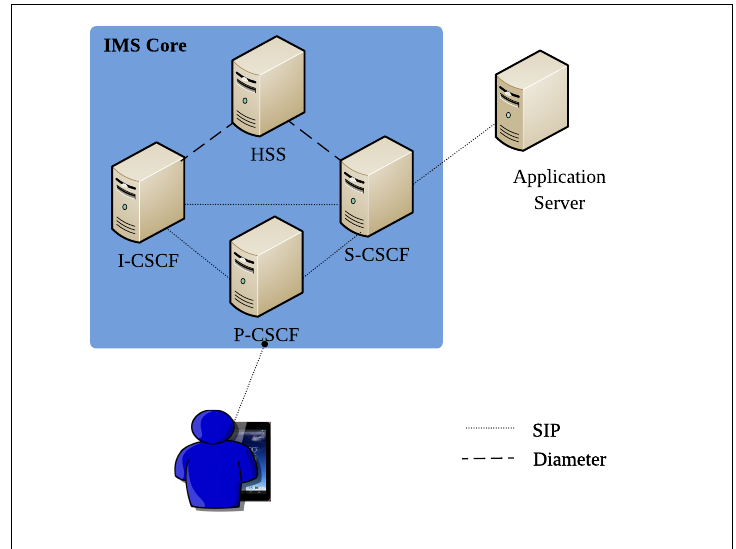
Figure 1. Brief network architecture of IMS.